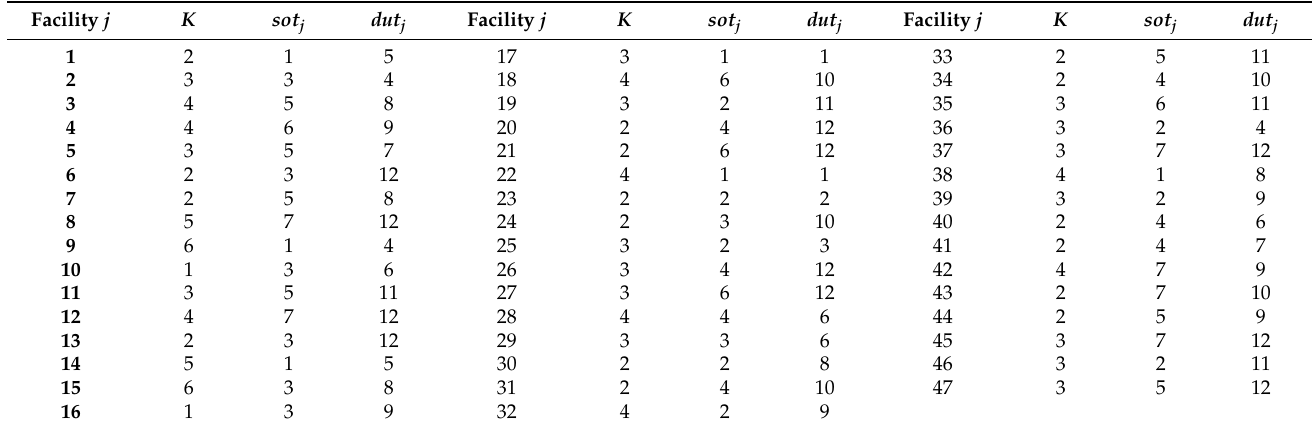
Table 3. Number of required tasks for each services with times.